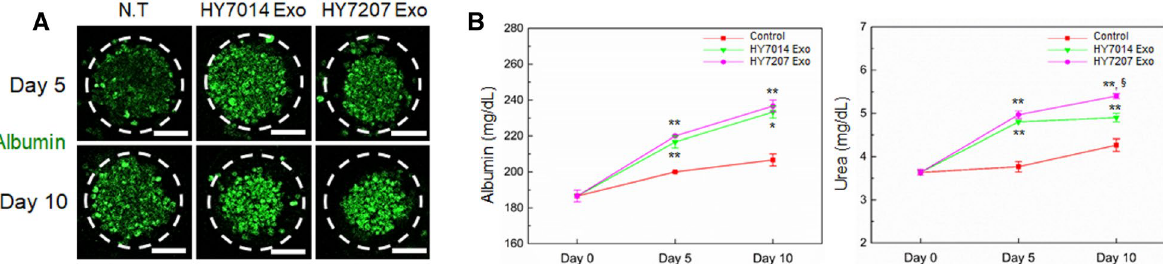
Fig. 7 A Immunostaining for serum albumin (green) in the hepG2 spheroids treated with various microbiota‑derived EVs for 10 days. The nuclei were stained with DAPI (blue). Scale bar are 50 μm. B Analysis of the function of microbial co‑cultured spheroids measuring in terms of the secretion of albumin (left) and urea (right). Data are represented as the mean SEM of three independent experiments. * p < 0.05 for control vs. each ± group, ** p < 0.01 for control vs. each group, and § p < 0.05 for HY7014 Exo vs. HY7207